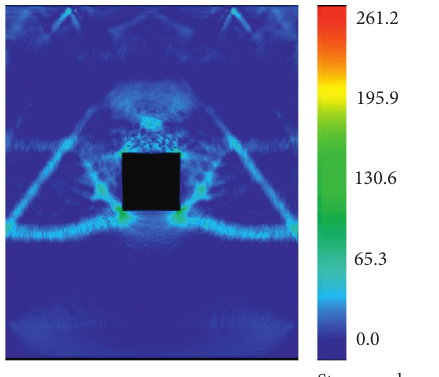
Figure 5: Fracture pattern of the numerical model with bolt in loading step 330.